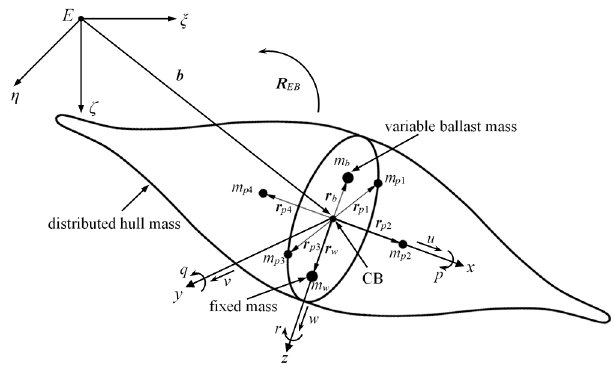
Figure 2. DTUG internal masses’ and frames’ assignment.